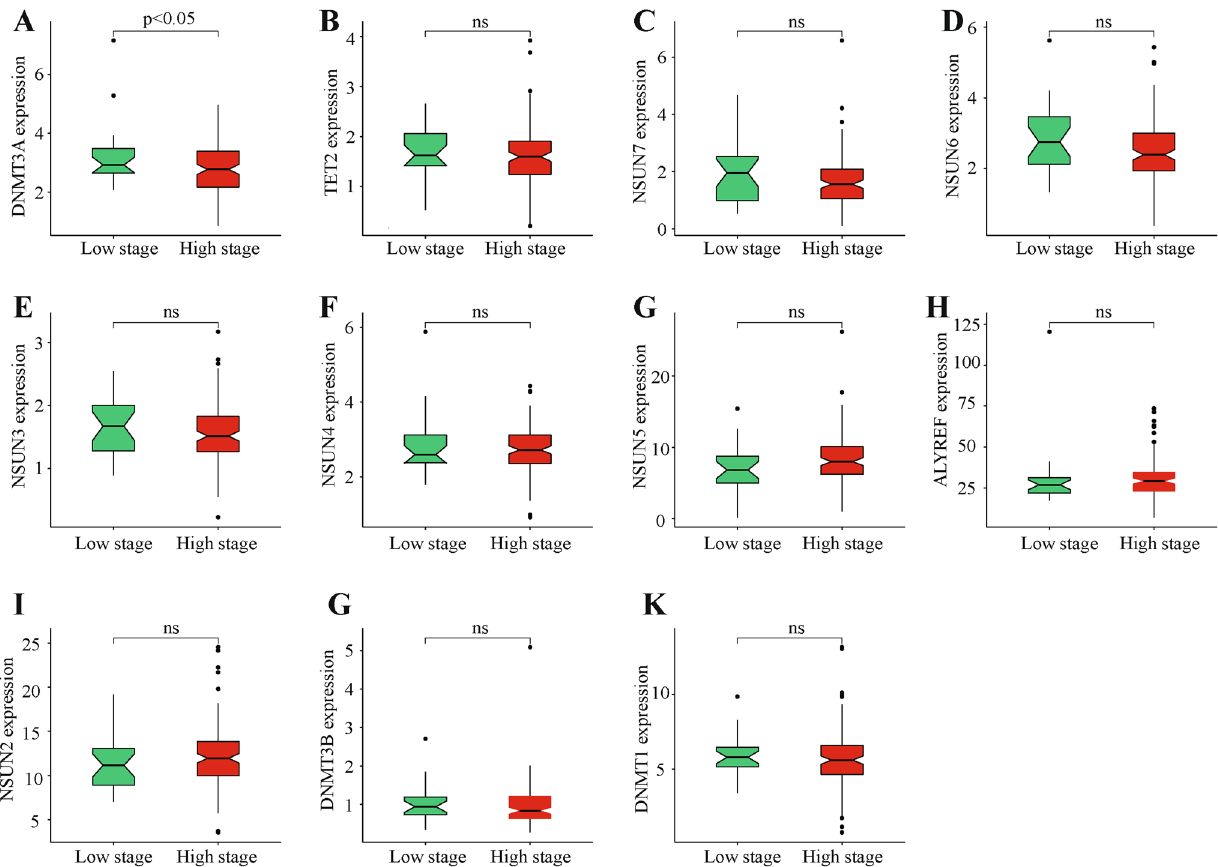
Figure 4. m5C regulatory gene expression in different clinically graded PAAD cases. ( A ) Comparison of m5C regulatory gene expression in different clinically graded cases. DNMT3A expression showed a significant negative correlation with patient clinical grade (significance P < 0.05). ( B – K ) Comparison of m5C regulatory gene expression in different clinically graded cases that were non-significant (ns).